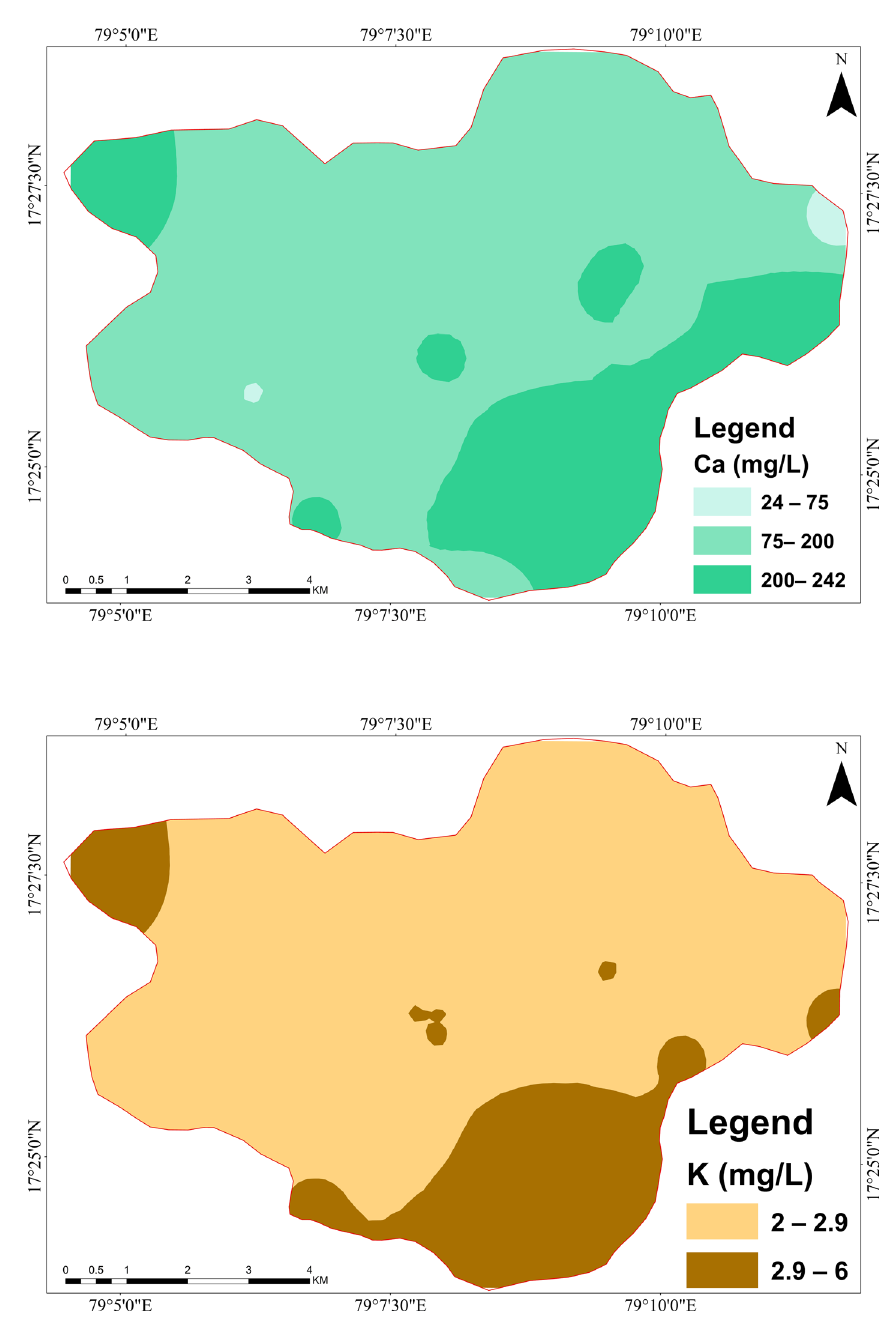
Fig. 7 Spatial distribution map of Ca 2+ in Mothkur region,